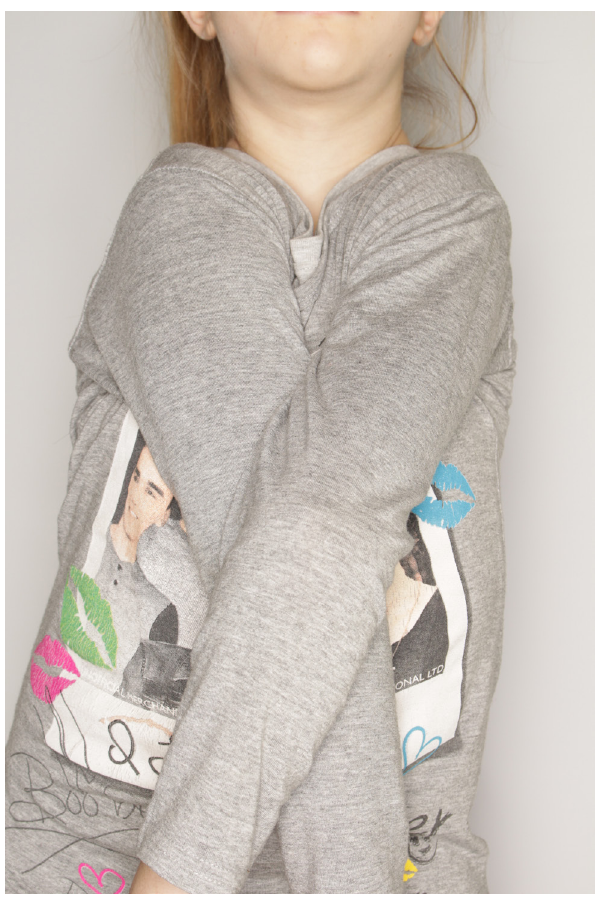
Figure 2 . The patient’s brachycephalic skull.